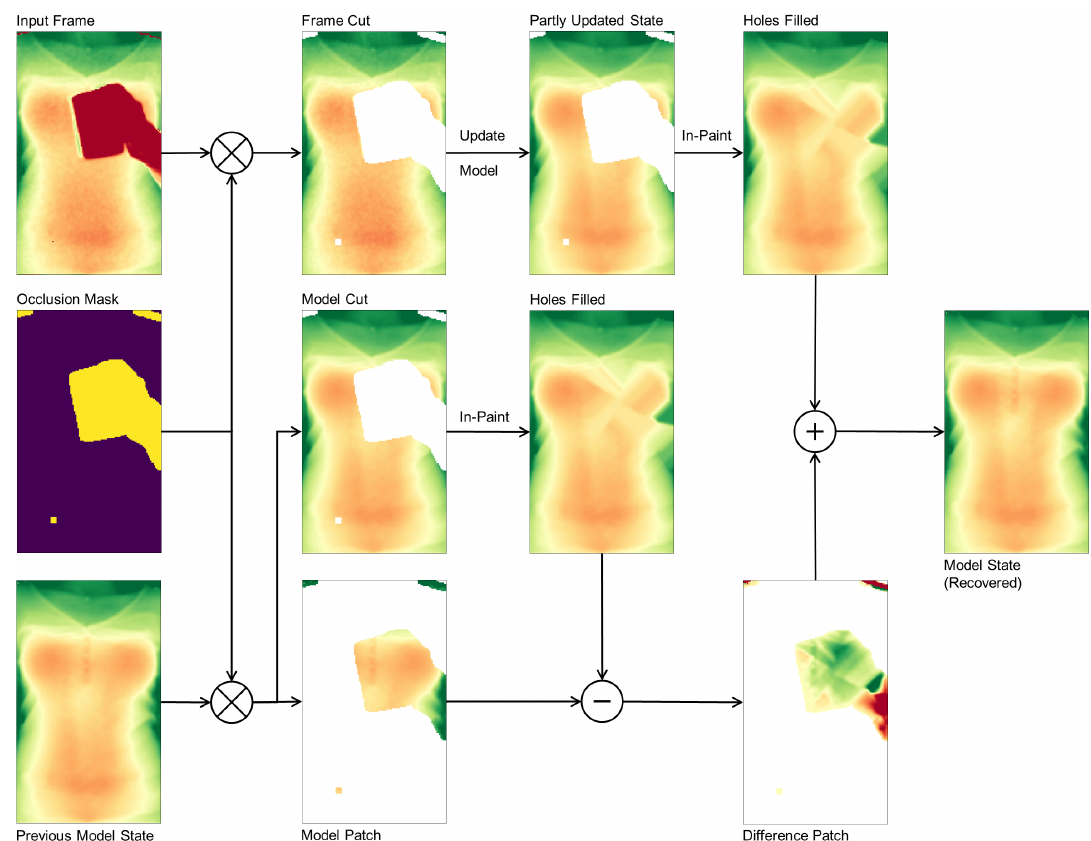
Figure 3. Detailed example of our occlusion recovery process: The depth input frame, occlusion mask, and previous model state are used. The occluded area is removed from the depth frame and the model state, with the model patch from the previous model state kept. The non-zero pixels from the depth input frame cut feed into the model update to yield a partly updated model state. The holes of both model states are in-painted, and the difference of the fitting model patch and the in-painted model cut is added to the in-painted area of the partly updated model state, yielding a new model state. First and second order derivatives are equally updated.